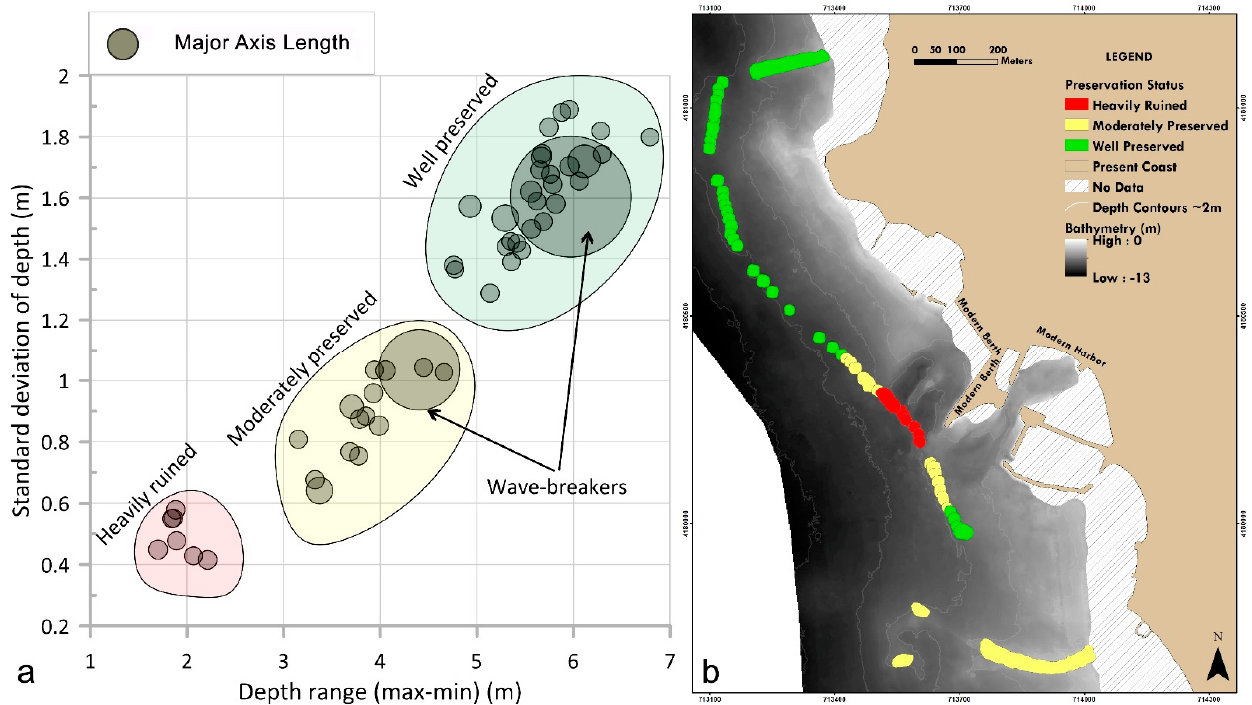
Figure 11. ( a ) Plot of the depth range ( x -axis) versus the standard deviation values ( y -axis) of the detected submerged showing their preservation status (circle radius corresponds to the length of the major axis of each detected element), and ( b ) a map showing their spatial extent, preservation status and the location of the modern harbour.